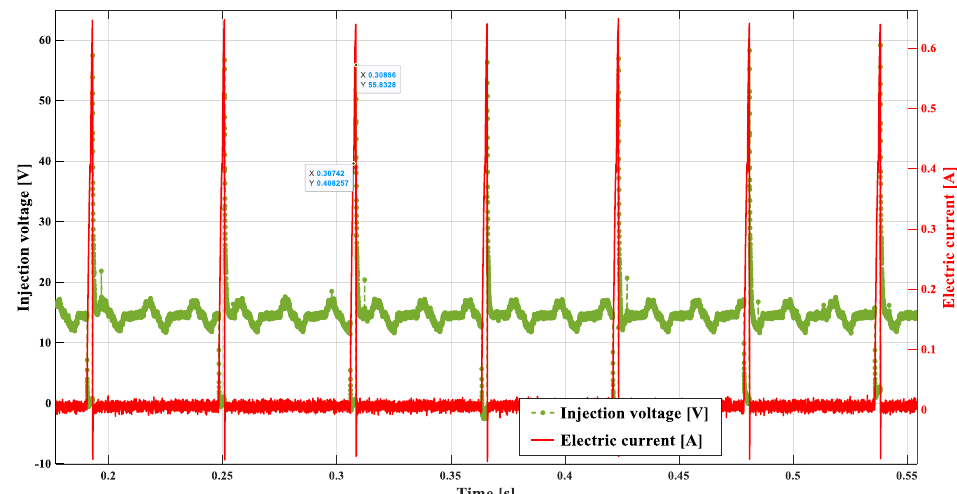
Figure 10. Example representation of cyclic injections at 2000 rpm.